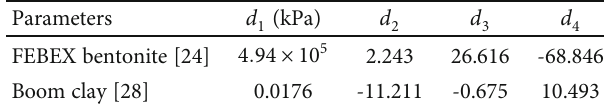
g in Eq. (17) for two di ff erent soils. , d , d , d 1 2 3 4